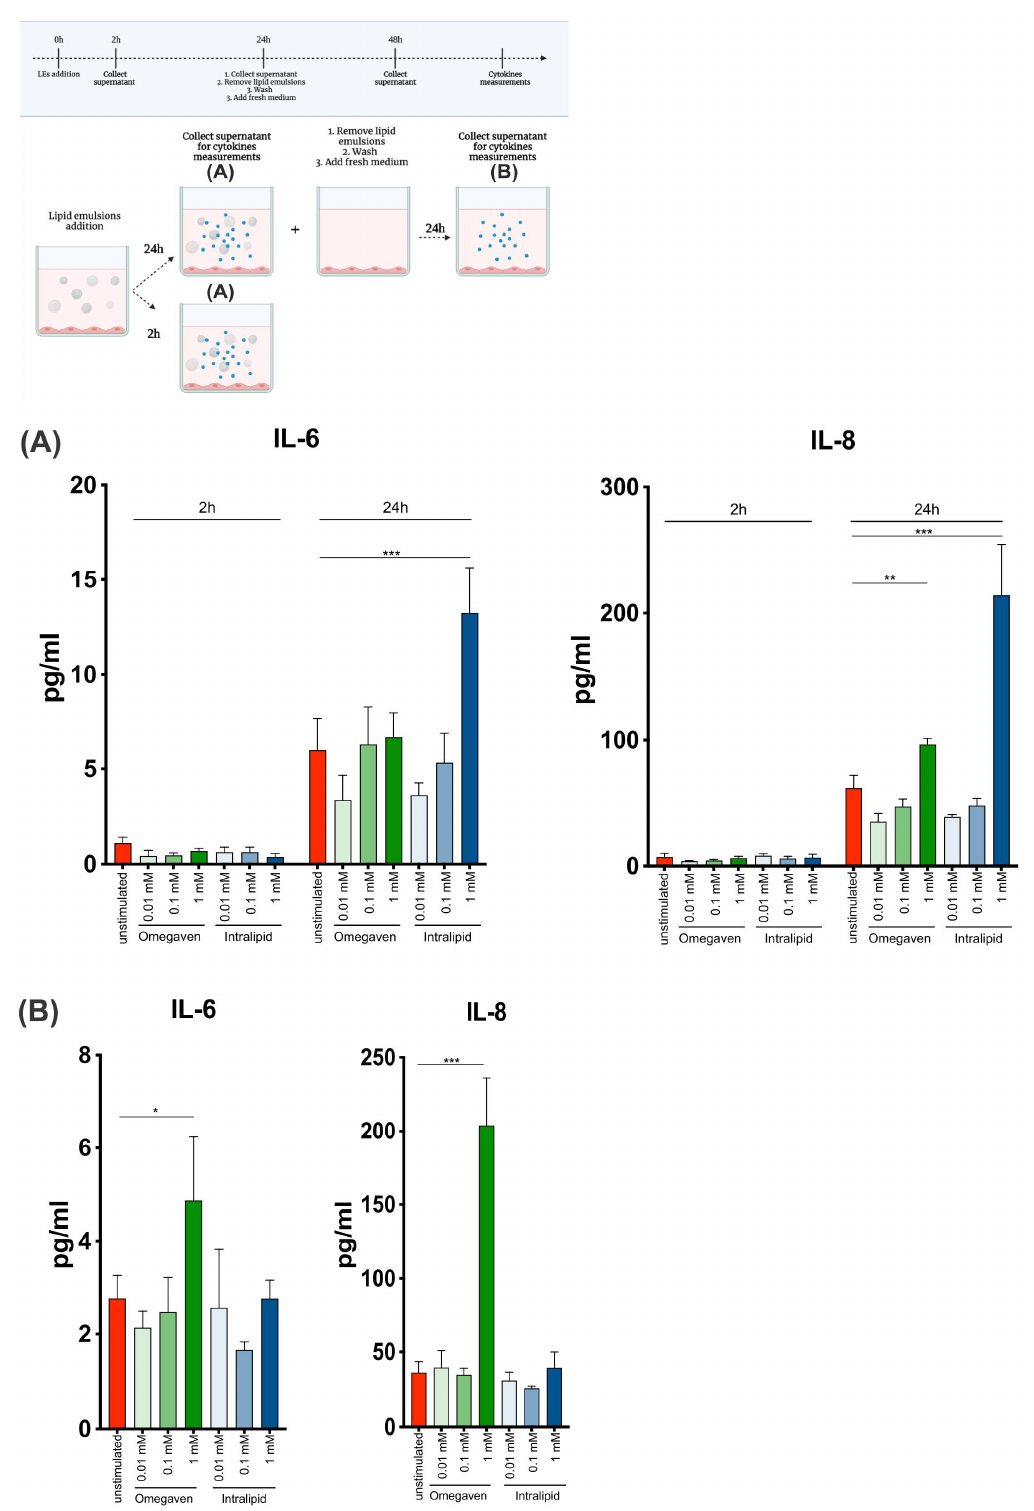
Figure 5. Lipid emulsions induce IL-6 and IL-8 cytokines production from endothelial cells. En- dothelial cells were cultured with 0.01, 0.1, 1 mM of Omegaven ® or Intralipid ® , and cell culture supernatant was collected at 2, 24 h ( A ). Next, the same cells were continued to culture in the presence of lipid emulsions for 24 h, lipid emulsions were removed, and fresh medium was added for the next 24 h ( B ). Finally, cytokines levels were measured with a multiplex cytokine assay (n = 3). (* p ≤ 0.05, ** p ≤ 0.01, *** p ≤